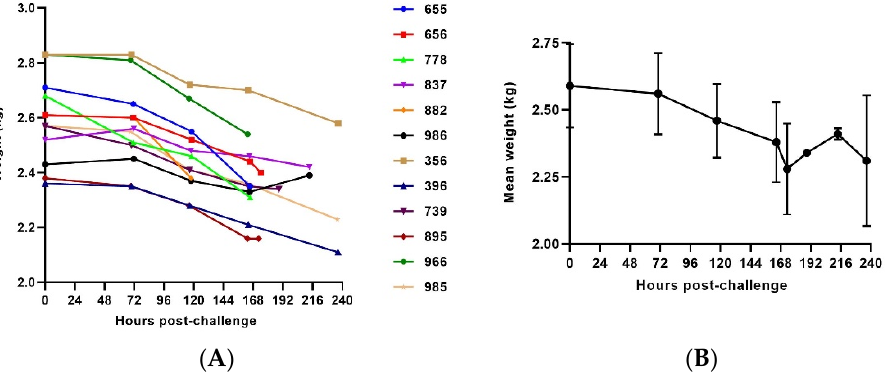
Figure 6. Body weight in SUDV-challenged NHPs. ( A ) Body weight evolution post-challenge. ( B ) Average weight. The error bars represent the standard deviation (SD).